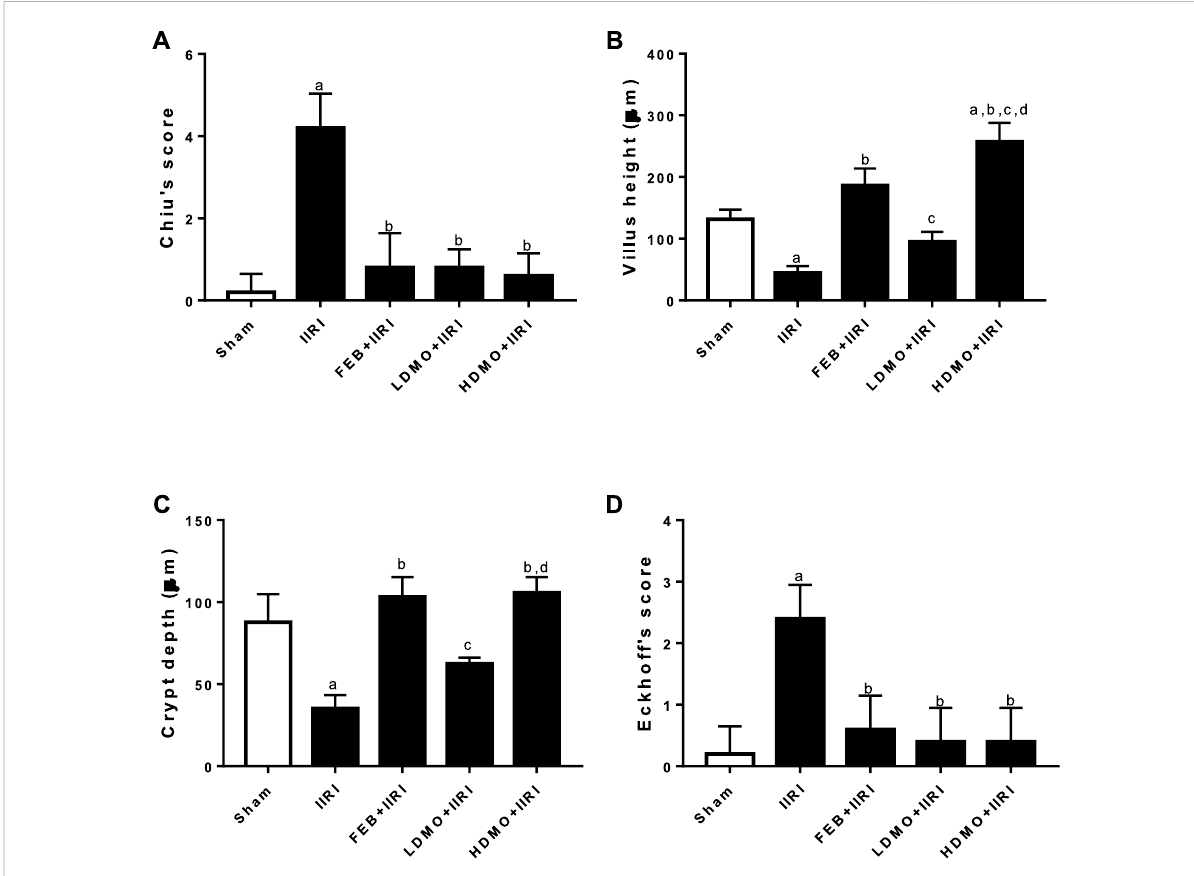
FIGURE 8 Effect ofintestinal ischaemia/reperfusion (I/R) and methanolic Moringa oleifera leaf extract on intestinalinjuryusing Chiu ’ s score (A) , villi height (B) , crypt depth (C) , and hepatic injury using Eckhoff ’ s score (D) . IIRI: Intestinal ischaemia/reperfusion injury, FEB: febuxostat, LDMO: low dose Moringaoleifera, HDMO:highdose Moringaoleifera, a p < 0.05versussham, b p < 0.05versusIIRI, c p < 0.05versusFEB+IIRI, d p < 0.05versusLDMO+ IIRI. Data were analyzed by one-way ANOVA followed by Tukey ’ s post hoc test. Values are expressed as mean ± SD of 10 rats per